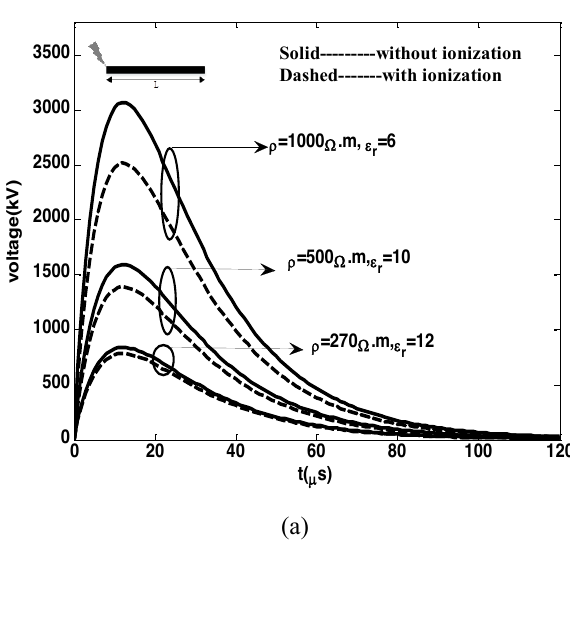
Figure 6: Time domain representation of the lightning current used in this